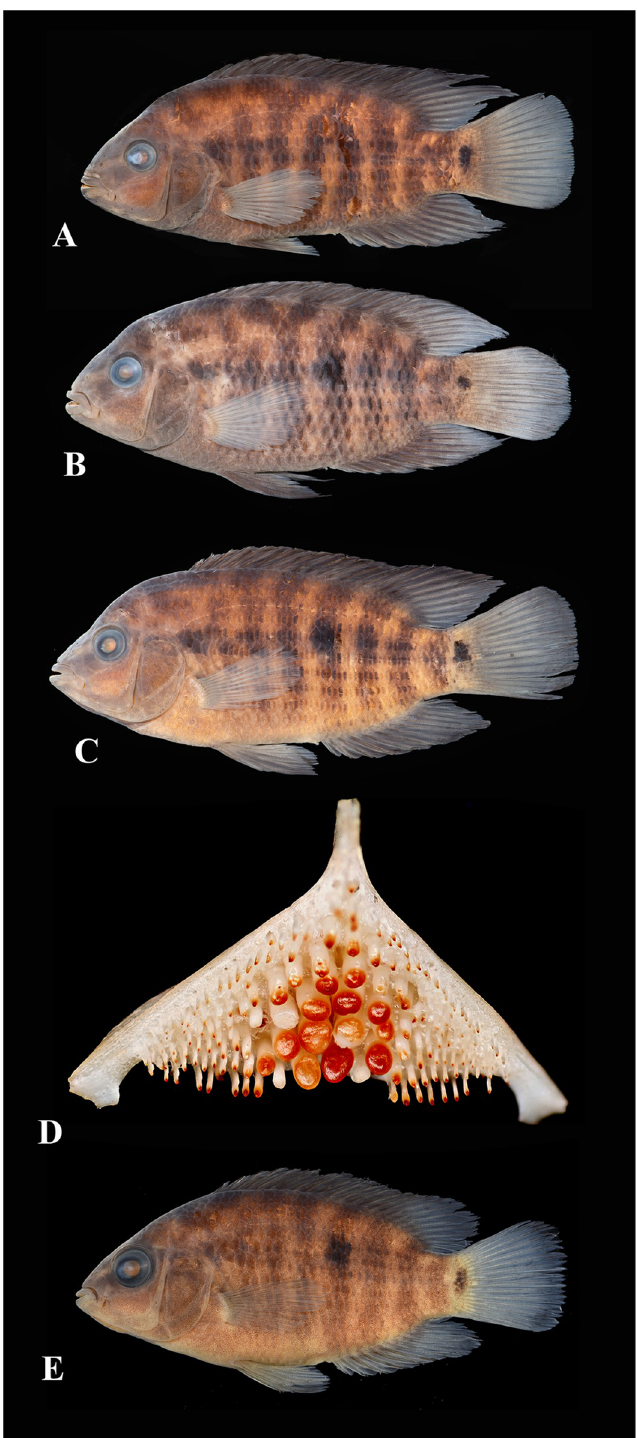
Fig 22. Australoheros minuano . A. adult female, 83.3 mm SL; Uruguay NRM 54147: Cerro Largo: Centurio´n: Paso del Centurio ´ n: Ca ñ ada Vigia, tributary to Rio Yaguaro ´ n about 2 km W of Rio Yaguaro ´ n. B. Adult female 87.8 mm SL; NRM 6140; Uruguay: Cerro Largo: Centurio´n: Paso del Centurio´n: Ca ñ ada Vigia, 2 km W of Rio Yaguaro´n. C. Adult female, 65.3 mm SL; NRM 54147; Uruguay; Cerro Largo: Centurio´n: Arroyo Ceibal down from bridge. D. NRM 54141, 42.2 mm SL mm SL; Lower pharyngeal tooth-plate in occlusal view. E. Australoheros minuano , young, 42.2 mm SL; NRM 54147, Uruguay; Cerro Largo: Centurio´n: Arroyo Ceibal down from bridge.